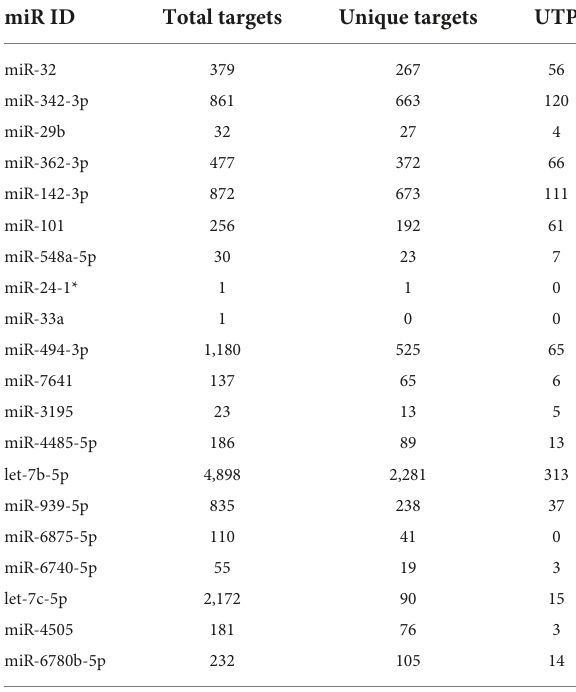
Figure 1B . Target gene prediction for the 11 miRs revealed 10,009 target genes consisting of 3,541 unique targets and 6,468 shared gene interactions.